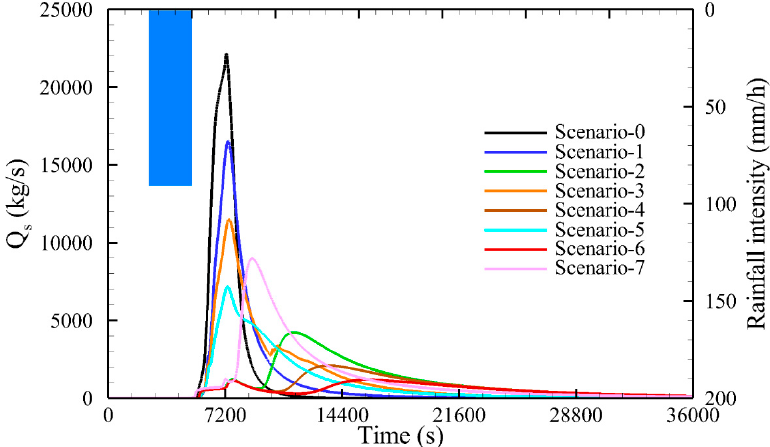
Figure 6. Sedigraphs at the catchment outlet under different scenarios (Q s : sediment discharge).